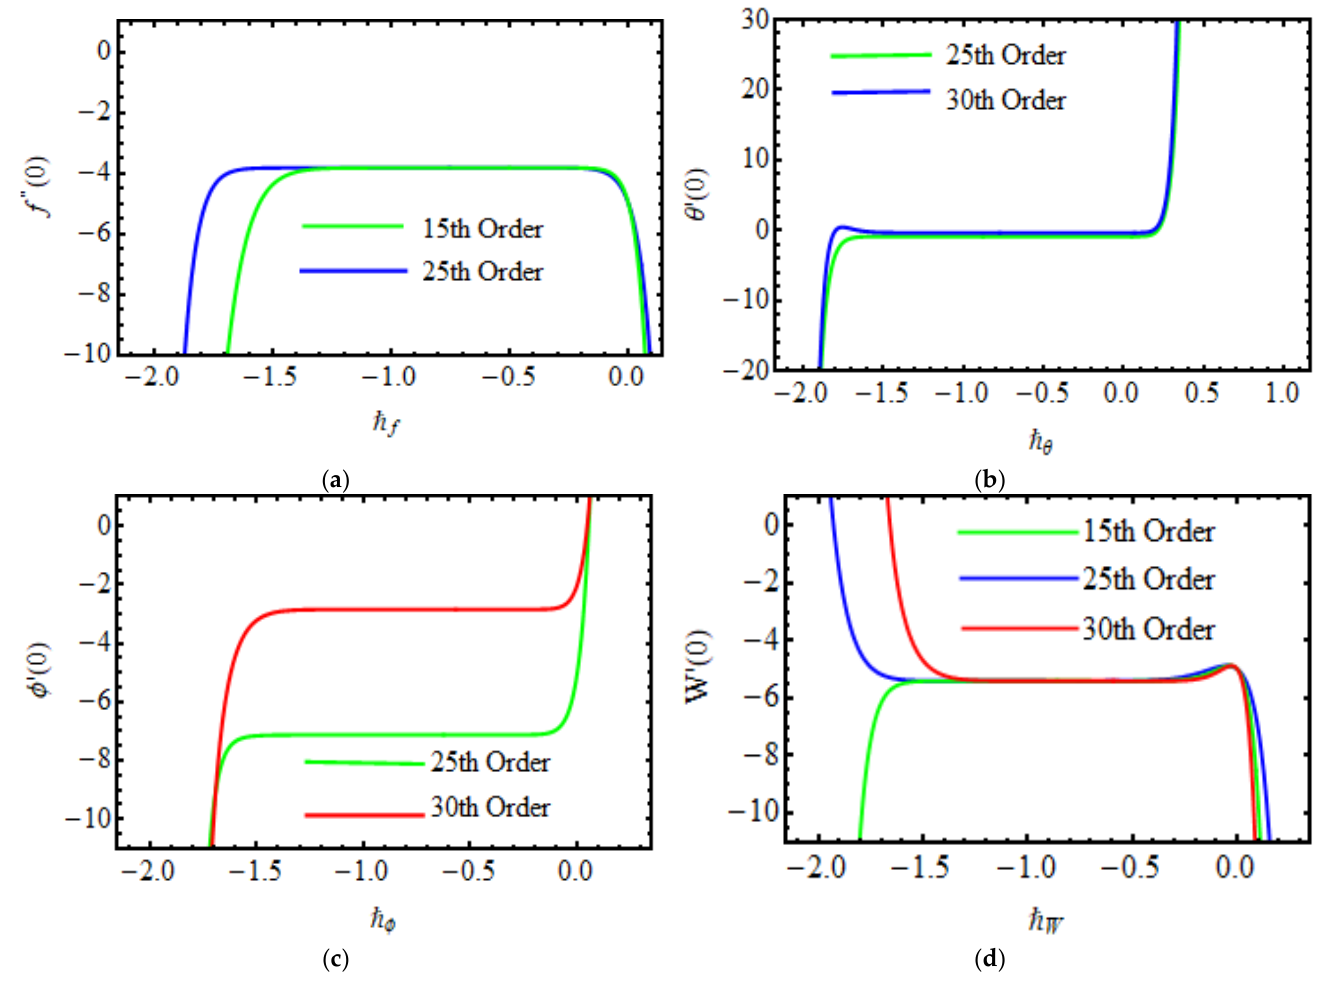
 the curve of '(0) θ ( c ) θ